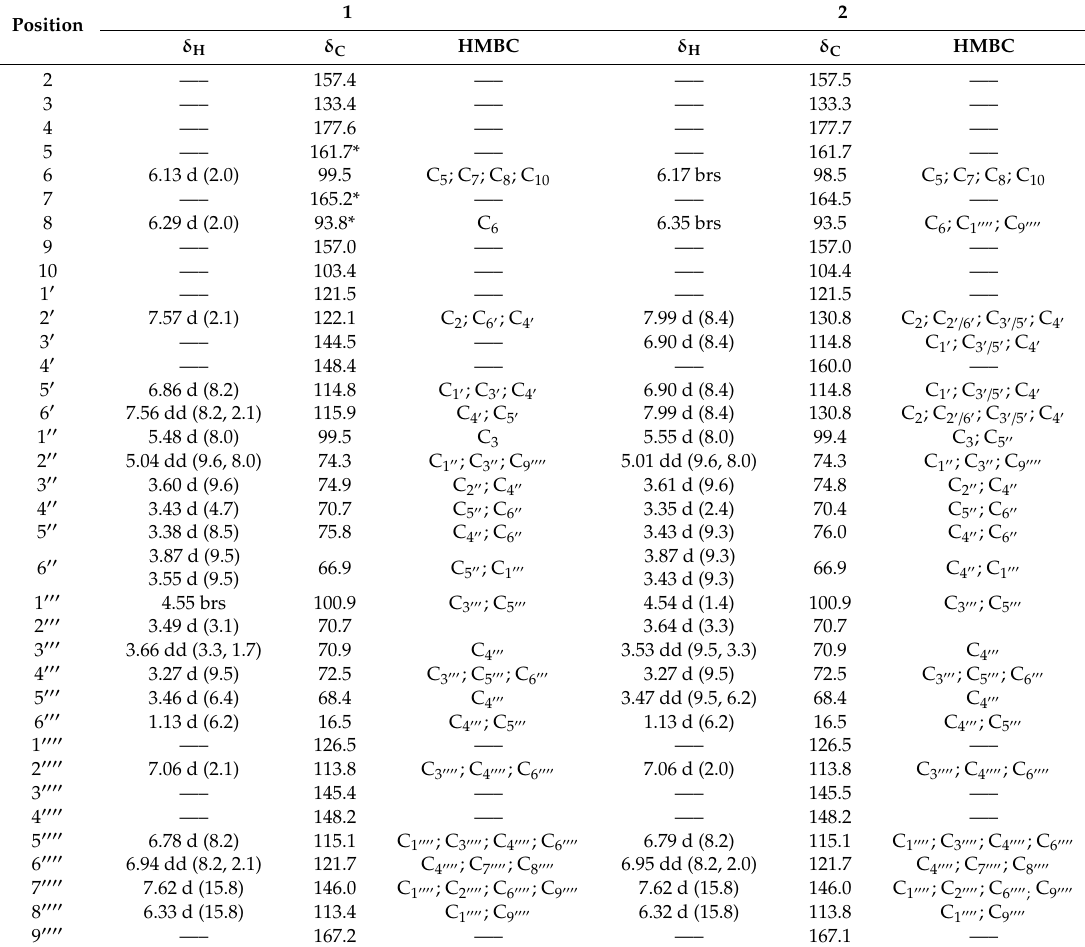
Table 1. 1 H, 13 C and HMBC NMR data of 1 and 2 ( δ in ppm, J in Hz, CD 3